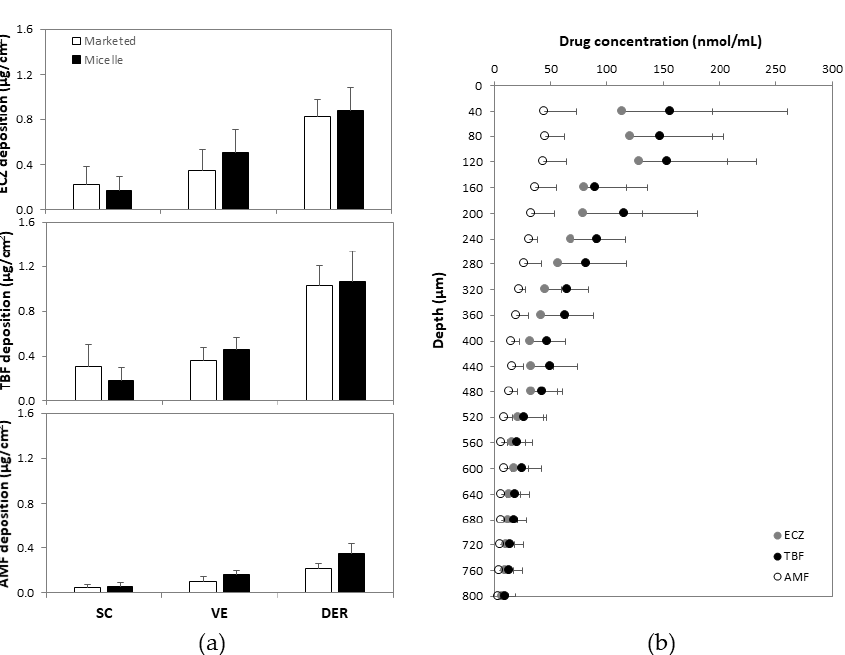
Figure 6. ( a ) Comparison of ECZ, TBF and AMF deposited in different anatomical regions in the skin—SC (stratum corneum, 0–40 µm), VE (viable epidermis, 40–160 µm) and DER (dermis, 160 µm)—from marketed formulations and from the “tri-therapy” (mean ± SD, n ≥ 5); ( b )